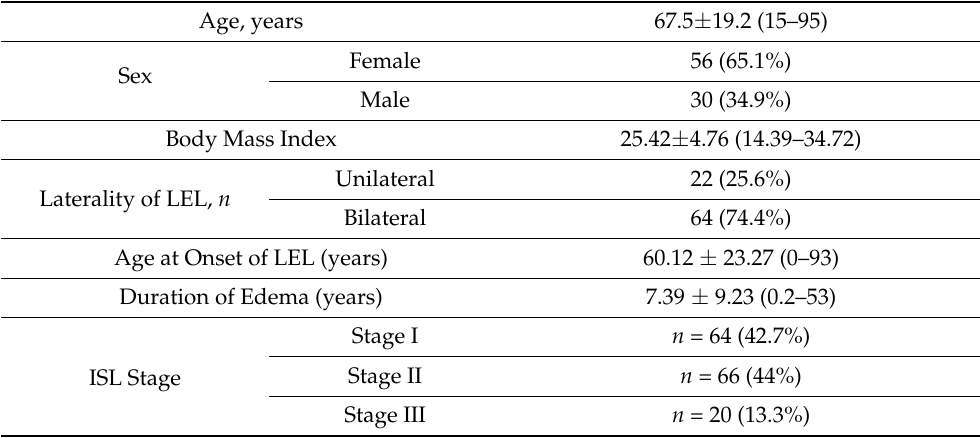
Table 1. Patient demographics and clinical details of 86 patients with primary lymphedema affecting 150 lower